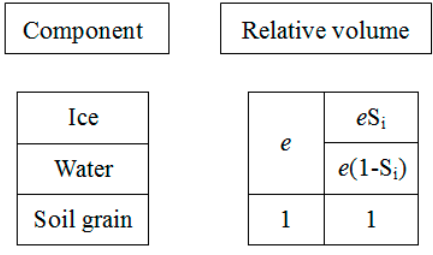
( b ) Figure 6. Ice lens distributions of soil columns at the end of Conditions I and II [18]: ( a ) Condition I with overburden pressure of 50 kPa; and ( b ) Condition II with overburden pressure of 100 kPa. 3. Numerical Example and Analysis In this section, a coupled thermo–hydro–mechanical model is used to elucidate the analysis on the experimental results of one-side freezing of soil columns in an open system, mentioned previously in Section 2. The moisture migration and change in void ratio during freezing are described herein, as well as associated problems in mathematics [12]. 3.1. Coupled Thermo–Hydro–Mechanical Equations 3.1.1. Moisture Transfer Figure 7 shows a three-phase diagram of saturated freezing soils. In the figure, e is the void ratio and S i is the ratio of the pore ice volume to the pore volume. In freezing soils, S i is a function of